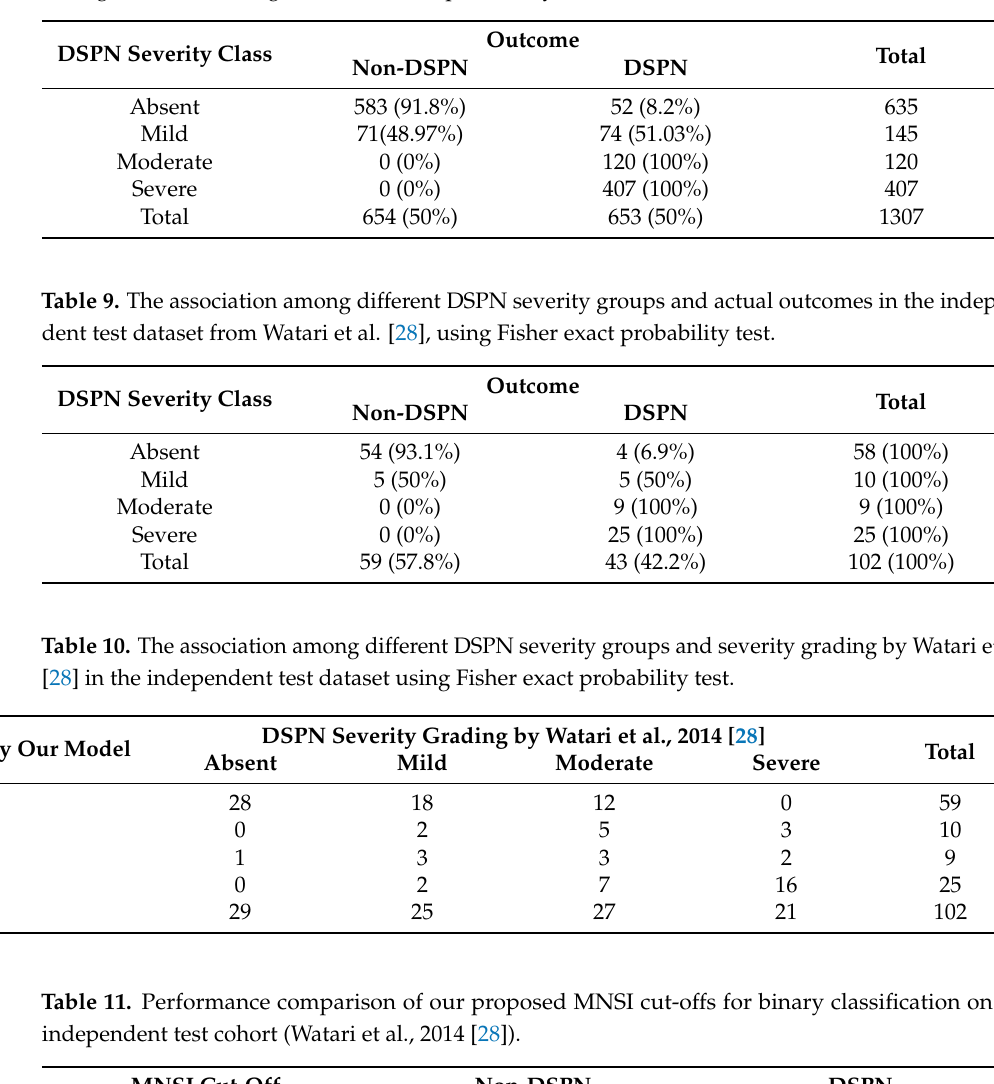
Table 8. The association among different DSPN severity groups and the actual outcomes in the EDIC testing dataset, utilizing the Fisher exact probability test.